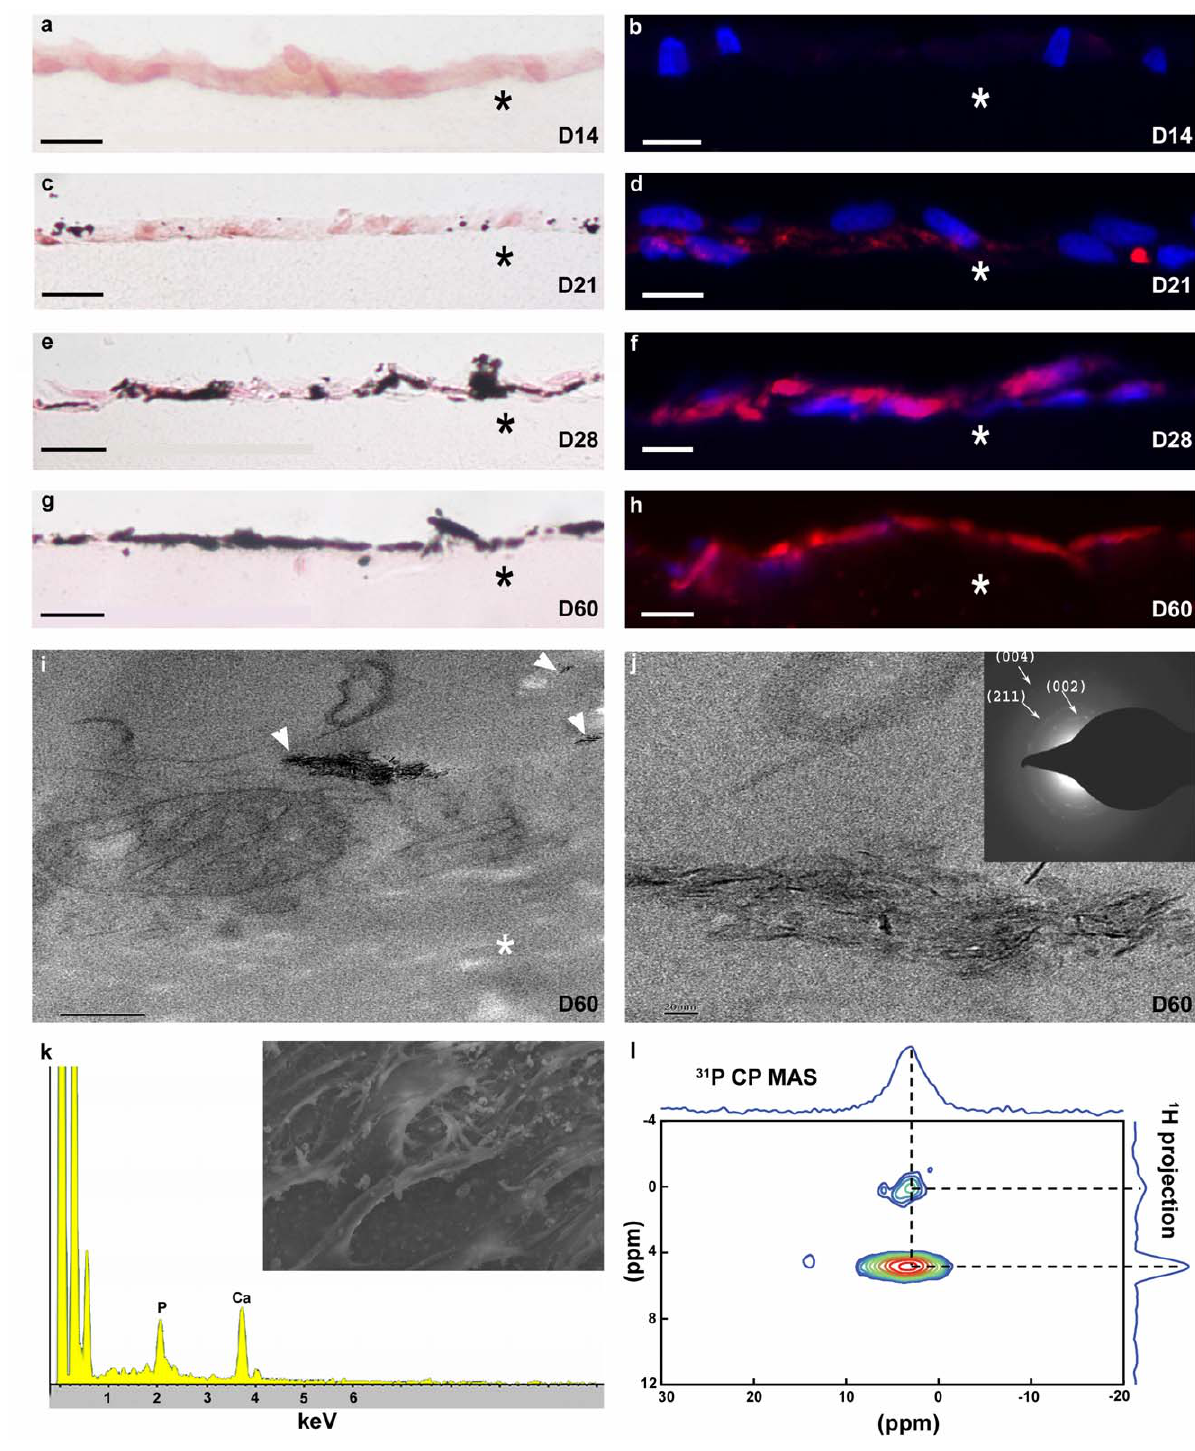
Figure 2. Demonstration of bone-like apatite formation at the surface of the osteoid-like matrix. a–h: Paraffin sections of matrices from 14 to 60 days. a, c, e, g: Staining with von Kossa indicates the presence of phosphate. b, d, f, h: Staining with alizarin red observed with epifluorescence (calcium in red, nucleus in blue) demonstrates the presence of calcium. Scale bars: a, e, f: 20 m m, b, d : 25 m m, c: 15 m m, g , h: 30 m m. i: Mineral deposits (arrowheads) observed in the osteoblast vicinity at day 60. j: High magnification showing apatite platelets. Scale bars: i: 200 nm, j : 20 nm. Inset : Electron diffraction pattern corresponding to the selected area. k: Calcium phosphate ratio analyzed by EDX coupled with SEM ( inset ) at day 60. l : 1D 31 P CP MAS and 2D 1 H- 31 P HETCOR experiment recorded at day 60, showing evidence of the biomimetic hydroxyapatite NMR fingerprint [correlation resonances between the phosphate groups d ( 31 P)=3 ppm and the hydroxyls and water d ( 1 H)=0 ppm and 4.8 ppm, respectively].